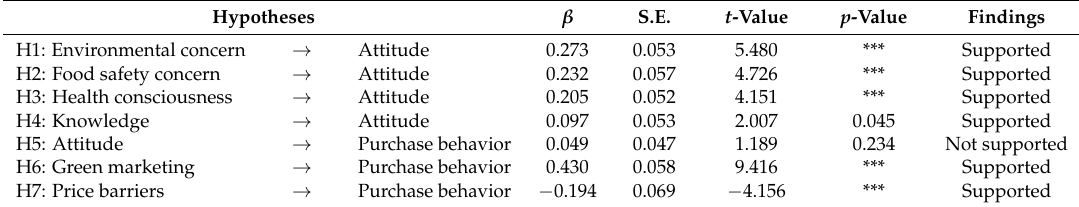
Table 4. SEM (structural equation modelling) results and hypotheses